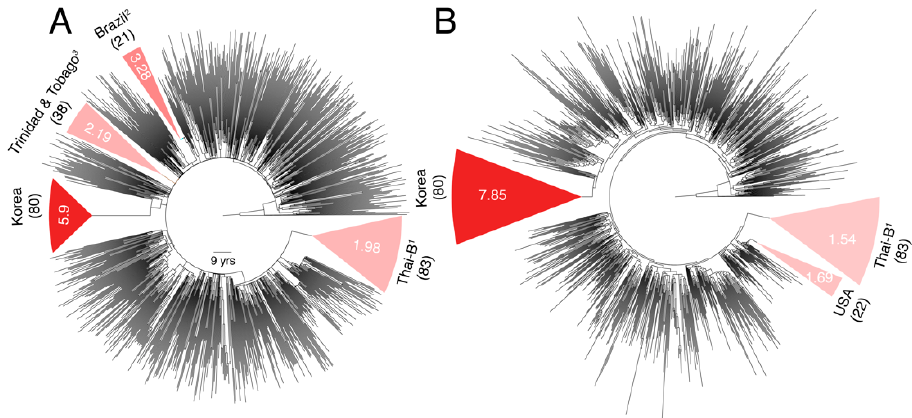
Figure 4. Comparison of env substitution rates among subtype B genetic variants. ( A ) Dated phylogeny comprising of a larger sampling of subtype B sequences is displayed. Partitions corresponding to monophyletic clades of B genetic variants sampled in Asia (Thai-B and Korean-B) and South America (Brazilian-B and Trinidad and Tobago B) are highlighted. Remaining branches correspond to B viruses sampled in rest of the World, primarily from North America and Europe. Numbers in parentheses indicate total number of tips in a clade. Values inside the clade indicate the calculated mean substitution rates. The 95% confidence intervals are not shown as they would not be legible (see text). Rates for the entire tree (i.e., without partitions) and remaining branches (i.e., excluding partitions) were 2.90 × 10 − 3 and 2.42 × 10 − 3 , respectively. RTT slope was 2.98 × 10 − 3 ( R 2 = 0.30, r = 0.55). ( B ) The node height of the tMRCA of the Korean-B clade was used to extract monophyletic partitions in the ML tree. Out of the eight identified partitions, three did not have sufficient temporal signal. Two partitions corresponded to the Trinidad and Tobago clade defined in ( A ) but were not analyzed because of the poor RTT signal (negative signal). The rates for the remaining three partitions are displayed. Other details similar to ( A ). 1 Includes 72 samples from China, 10 from Thailand, and 1 from Myanmar (1), 2 also includes 1 sample from Argentina, 2 from France, 1 from China, 2 from USA, and 1 from Ukraine, 3 also includes 1 sample from